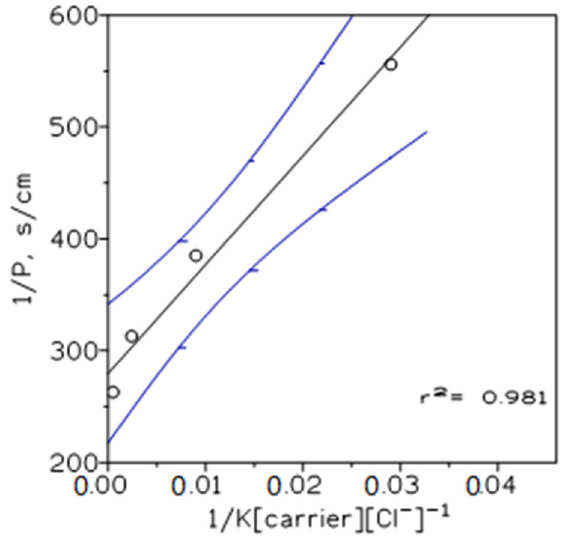
Figure 4. Plot of 1/P versus 1/K[carrier][Cl − ] − 1 . Dotted line indicates a 95% confidence interval of the Figure 4. Plot of 1 / P versus 1 / K[carrier][Cl − ] − 1 . Dotted line indicates a 95% confidence interval of the regression line. regression